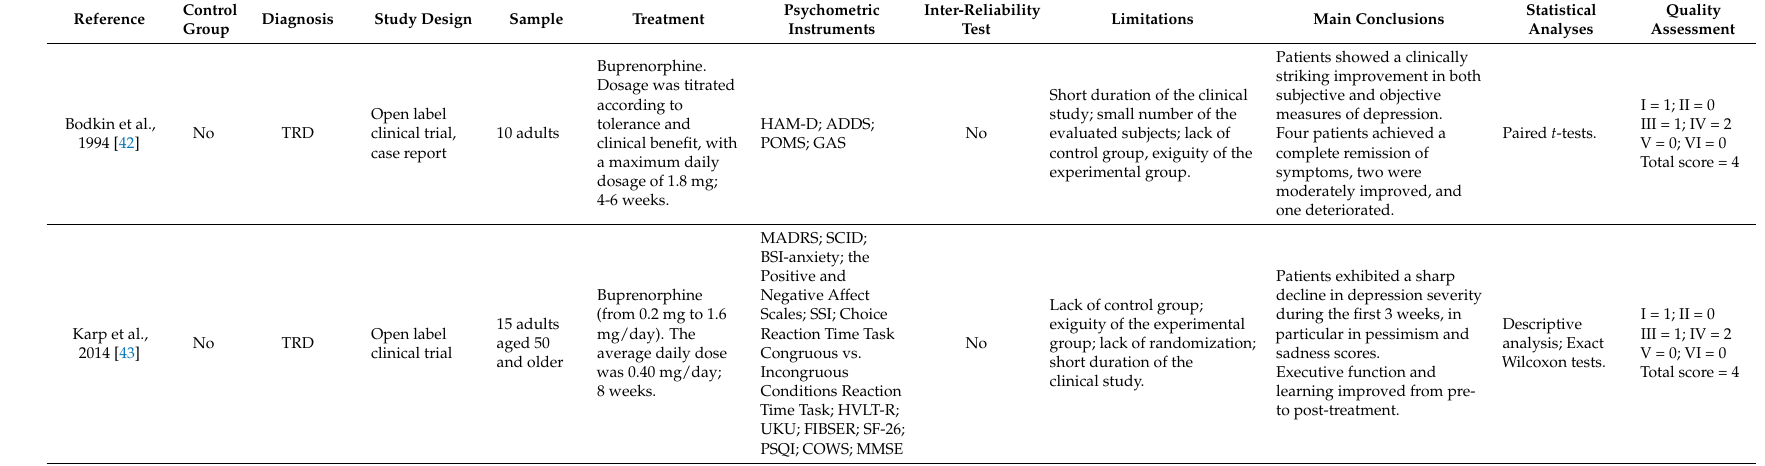
Table 3. Summary of the most relevant open label non-controlled clinical trials concerning BUP and depression/suicidal behavior included in the present